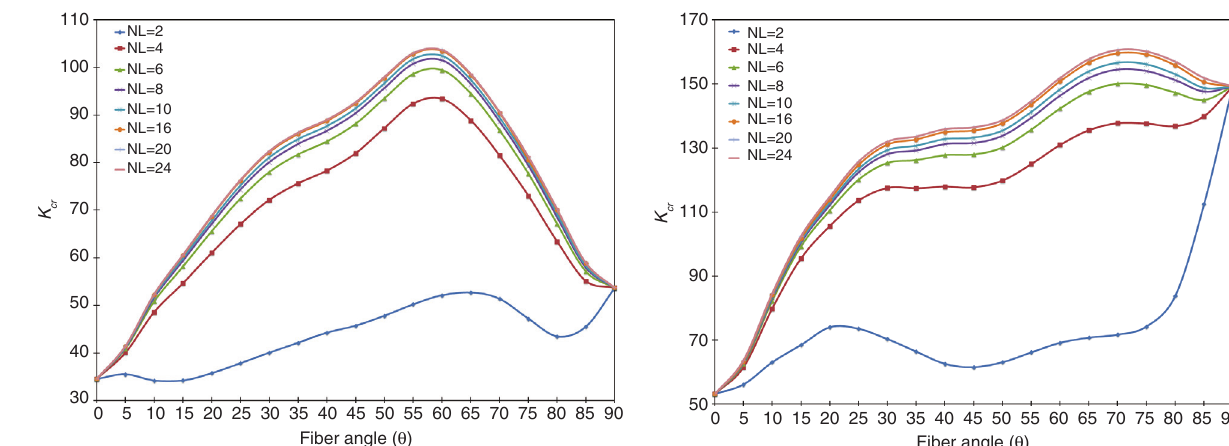
Figure 12 Critical buckling load parameter for clamped antisym- metric cylindrical skew panel (Ø = 15 ° , α = 15 ° ).